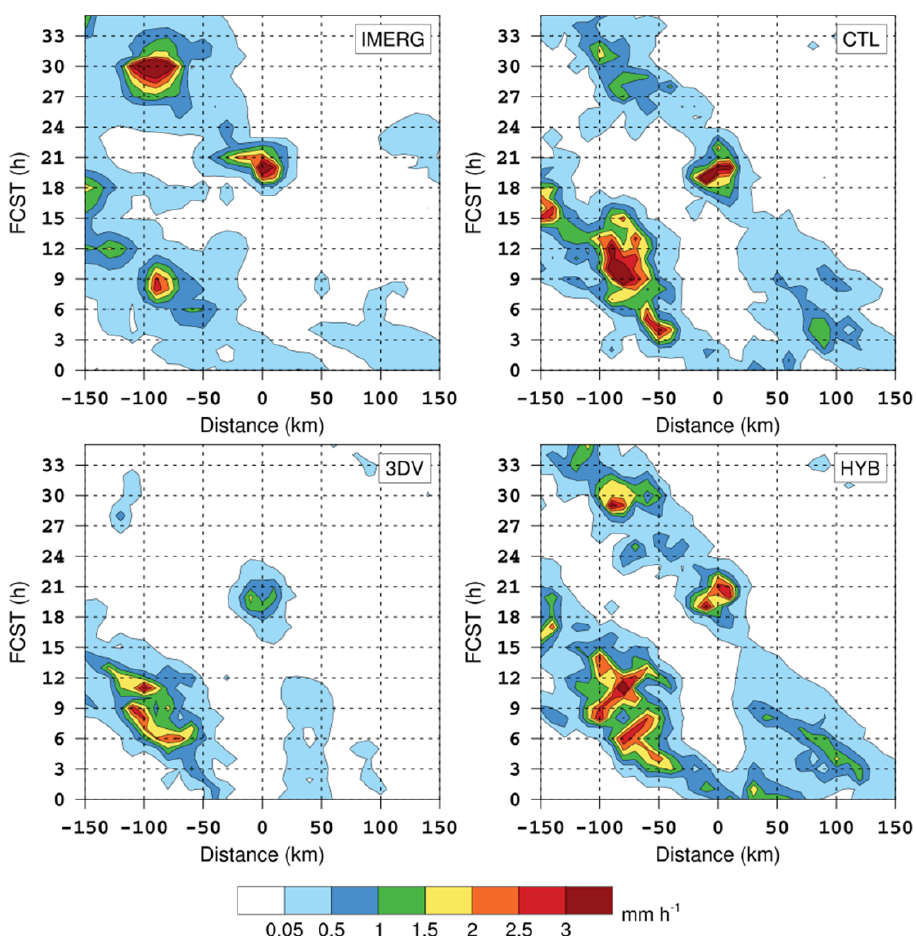
Figure 11. Hovmöller diagrams of hourly precipitation rate from IMERG data and WRF experiments (CTL, 3DV, HYB) during Case 5, averaged in the solid black transect shown in Figure 2.